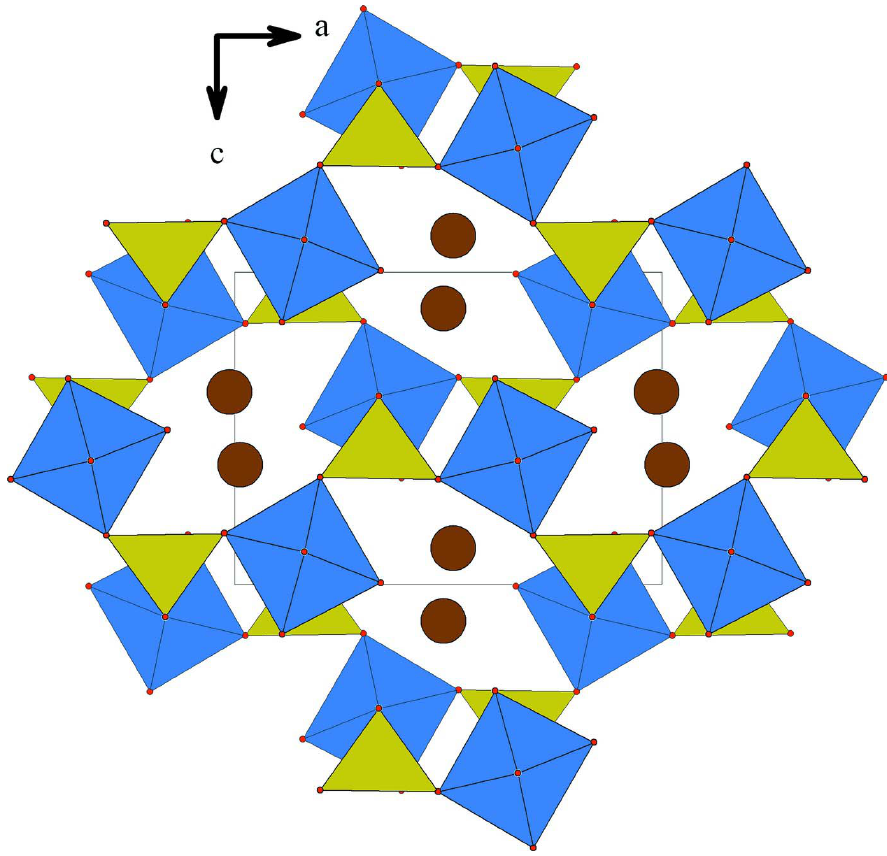
AsO selon b montrant les canaux où résident les cations Na + . 2 4